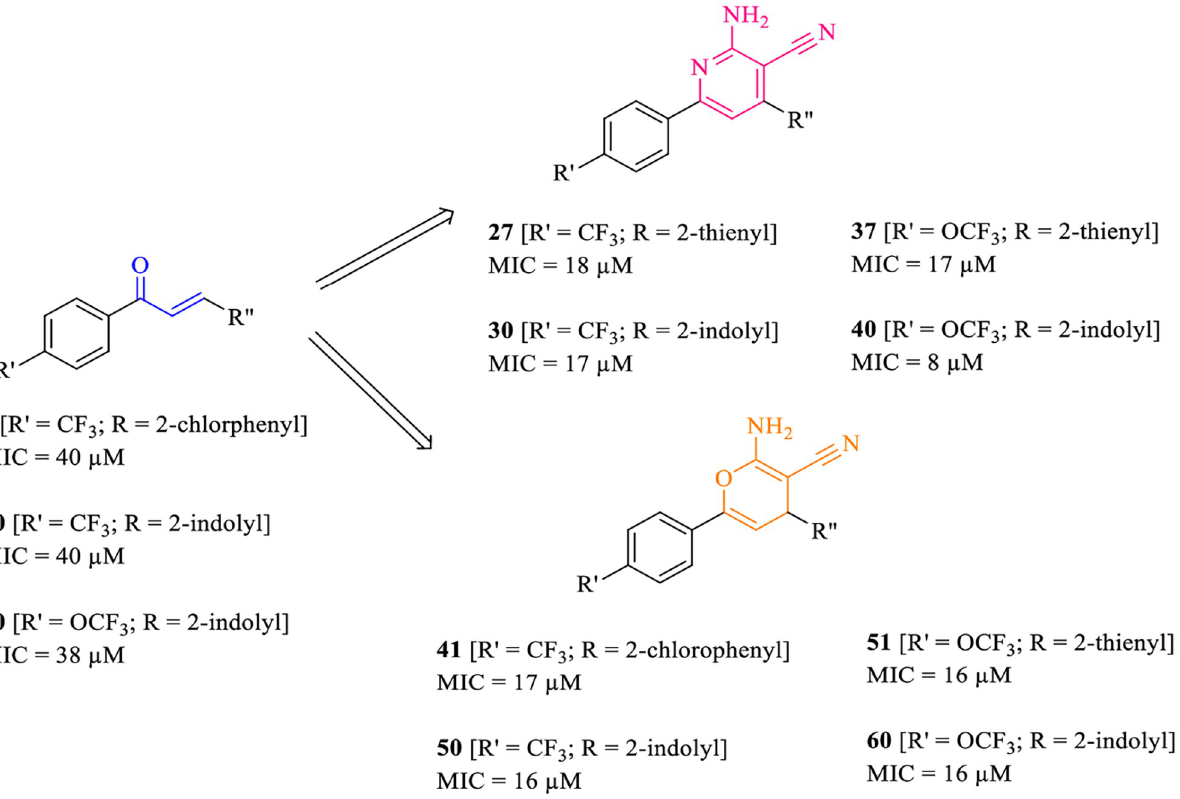
Fig 4. Summary of the antitubercular activities of fluorinated chalcones (1–20), 2-amino-pyridine-3-carbonitrile (21–40) and 2-amino-4H-pyran- 3-carbonitrile (41–60) derivatives.